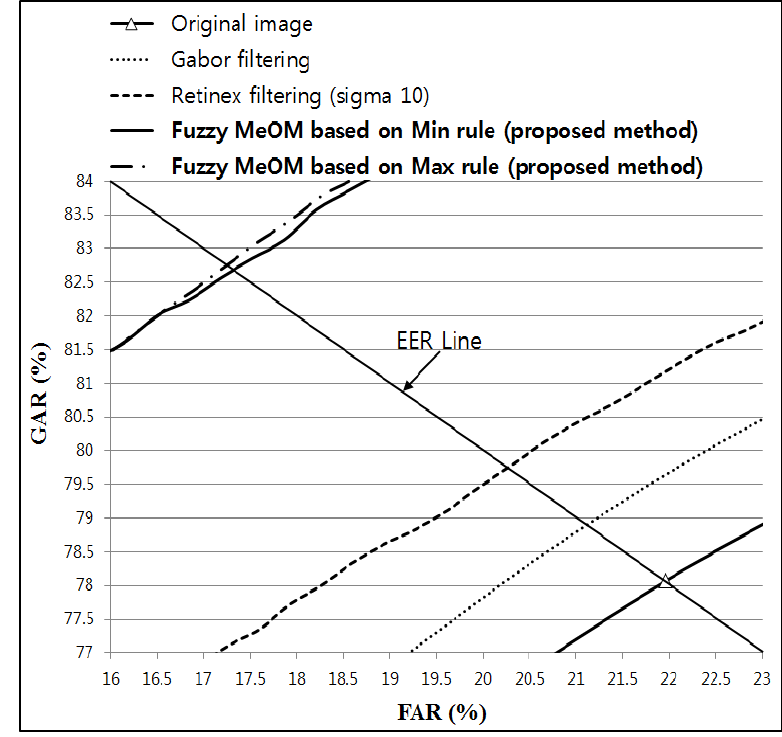
Figure 23. ROC curves obtained using the proposed method with Gabor filtering and Retinex filtering, with a sigma value of 10, and a Haar wavelet for images from database I.